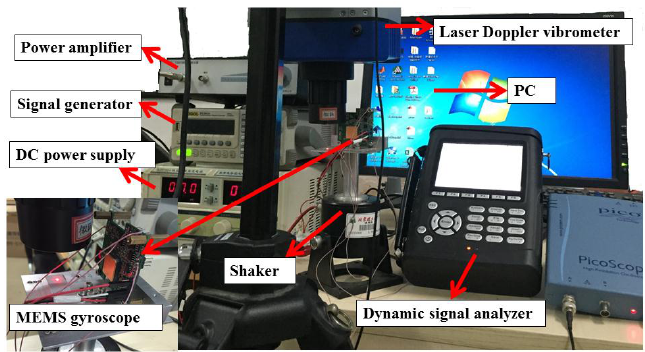
Figure 6. The experimental setup.